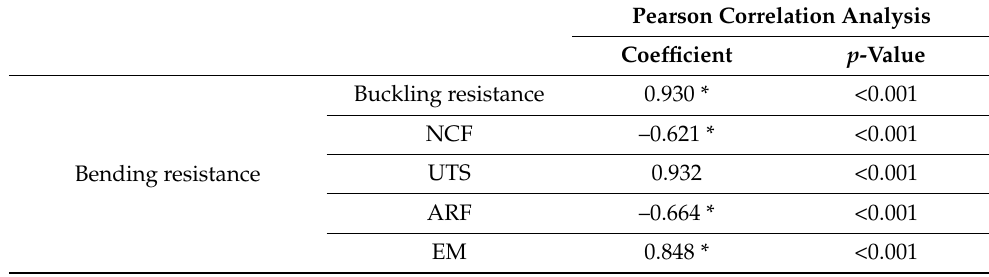
Figure 4. Scanning electron microscopic photographs of TruNatomy Prime ( A1 – A4 ), XP-endo Shaper ( B1 – B4 ), Spring Endo ( C1 – C4 ), and Spring H ( D1 – D4 ) files after the torsional resistance test. ( A1 , B1 , C1 , D1 ) (×250) fractured surface; ( A2 , B2 , C2 , D2 ) (×1000) magnified view of sections indicated by arrows in A1 , B1 , C1 , and D1 , respectively; ( A3 , B3 , C3 , D3 ) (×250) lateral surface; ( A4 , B4 , C4 , D4 ) (×1000) magnified view of sections indicated by arrows in A3 , B3 , C3 , and D3 , respectively. Table 3. Pearson correlation